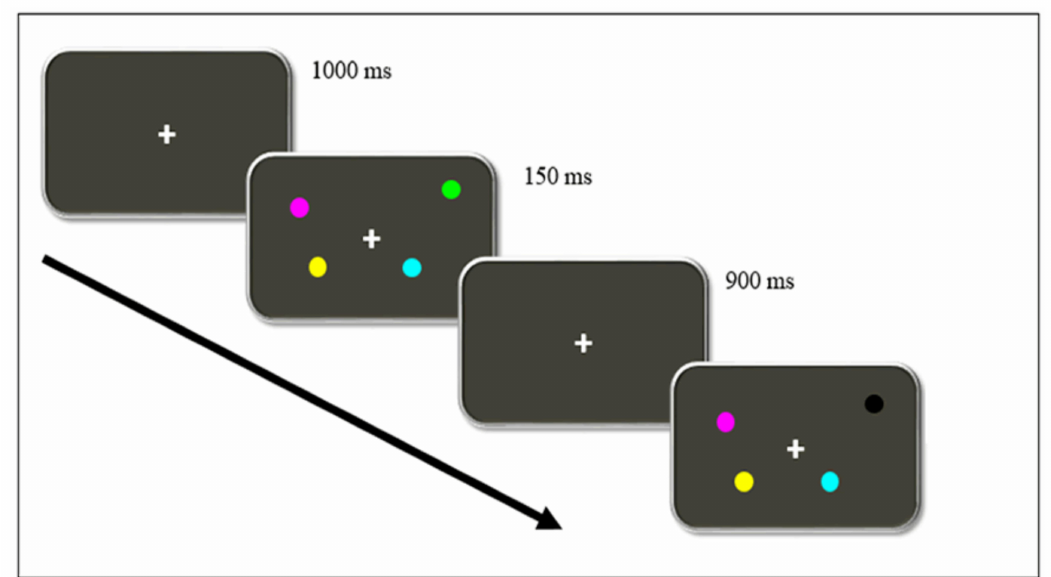
Figure 1. Timeline of events of a single trial in the Change Localization Task. Participants must identify which circle changed its colors between each exposure. In this example, they must point the mouse to the black